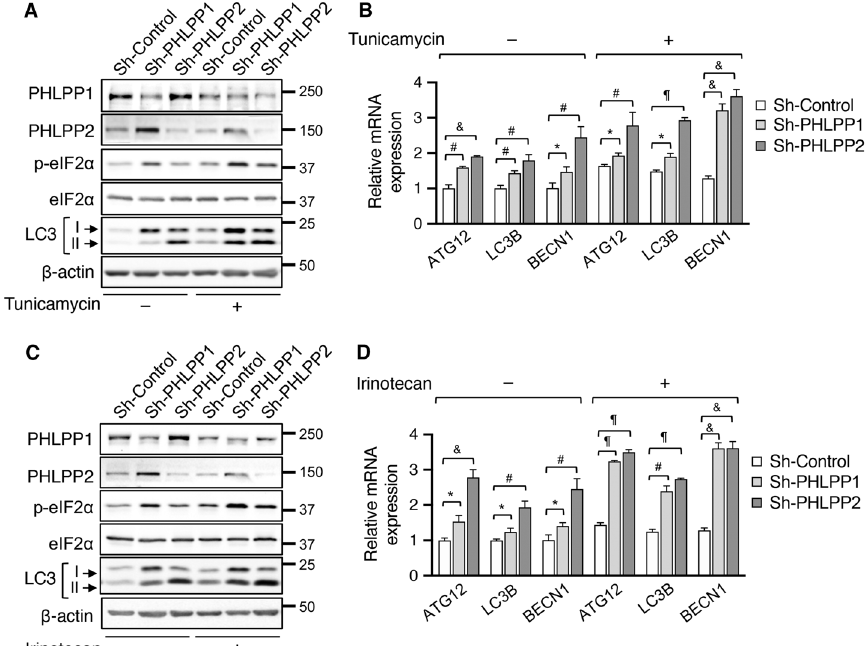
Fig. 4 Knockdown of PHLPP1 or PHLPP2 enhances ER stress-induced autophagy response in colon cancer cells. a Control (sh-Control) and PHLPP knockdown (sh-PHLPP1 and sh-PHLPP2) SW480 cells were treated with DMSO or tunicamycin for 12 h. Cell lysates were analyzed for the expression of PHLPP1, PHLPP2, p-eIF2 α , eIF2 α , LC3, and β -actin using Western blot. The position of LC3-I and LC3-II was marked by arrows. b The relative expression of ATG12 , MAP1LC3B (LC3B) and BECN1 mRNA in DMSO or tunicamycin-treated cells was determined using RT-qPCR. Data represent the mean ± SD (¶ p < 0.0001, & p < 0.001, # p < 0.01, and * p < 0.05). c Control (sh-Control) and PHLPP knockdown (sh-PHLPP1 and sh-PHLPP2) SW480 cells were treated with DMSO or irinotecan overnight. Cell lysates were analyzed for the expression of PHLPP1, PHLPP2, p-eIF2 α , eIF2 α , LC3, and β -actin using Western blot. d The relative expression of ATG12 , MAP1LC3B (LC3B) and BECN1 mRNA in DMSO or irinotecan treated cells was determined using RT-qPCR. Data represent the mean ± SD (¶ p < 0.0001, & p < 0.001, # p < 0.01, and * p < 0.05).